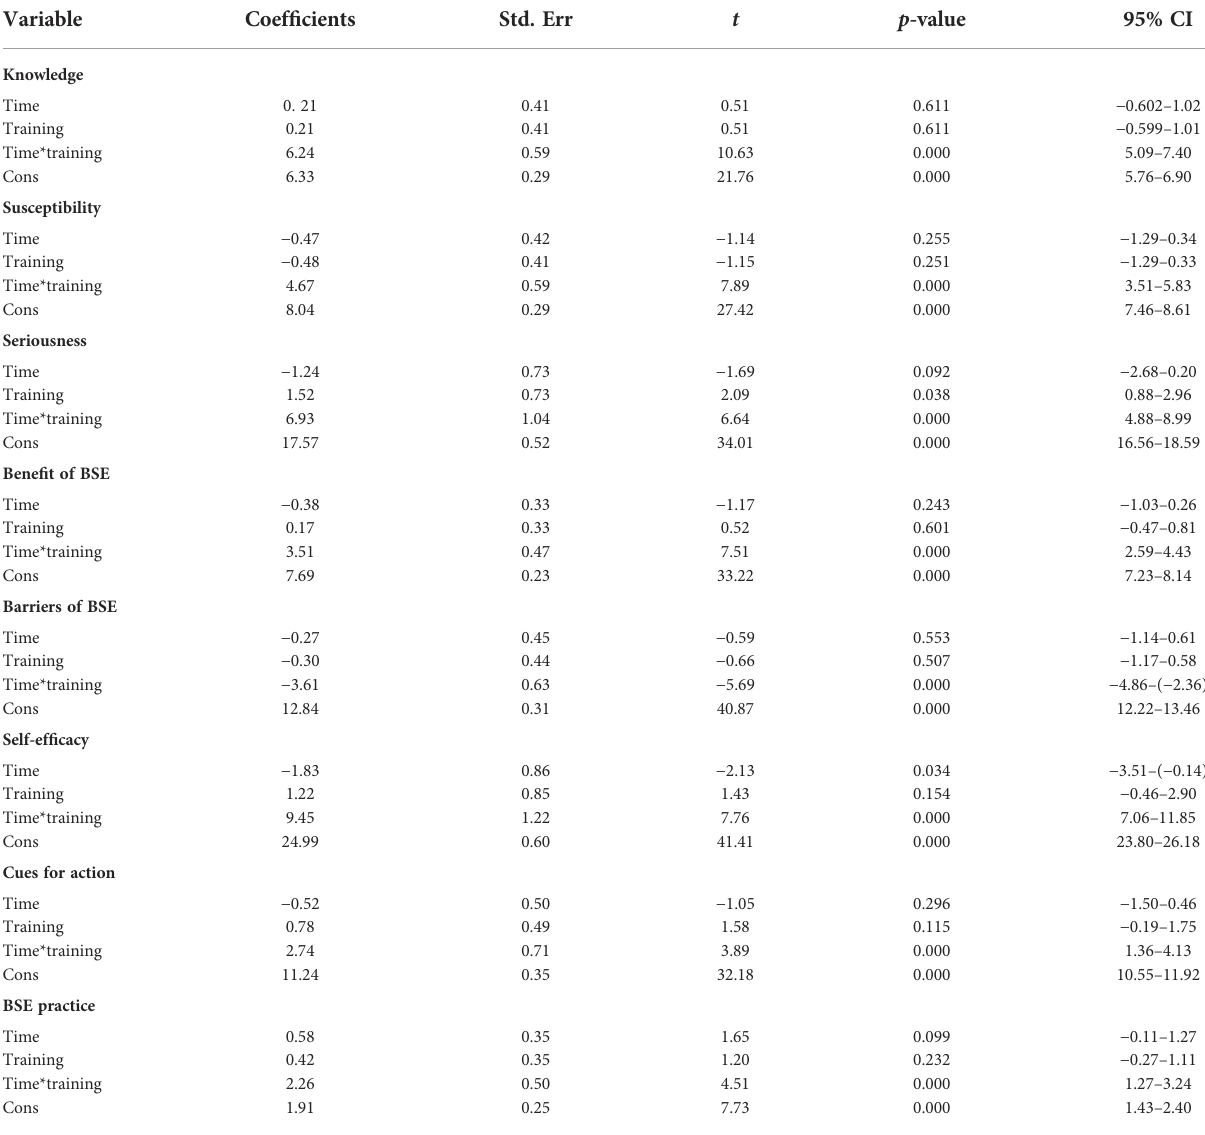
TABLE 5 Difference in difference about total knowledge, health belief, and BSE practice score among female students of Debre Markos University, Amhara, Ethiopia before and 1 month after educational intervention about BC based on HBM ( n = 210) 2021. Variable Coef fi cients Std.